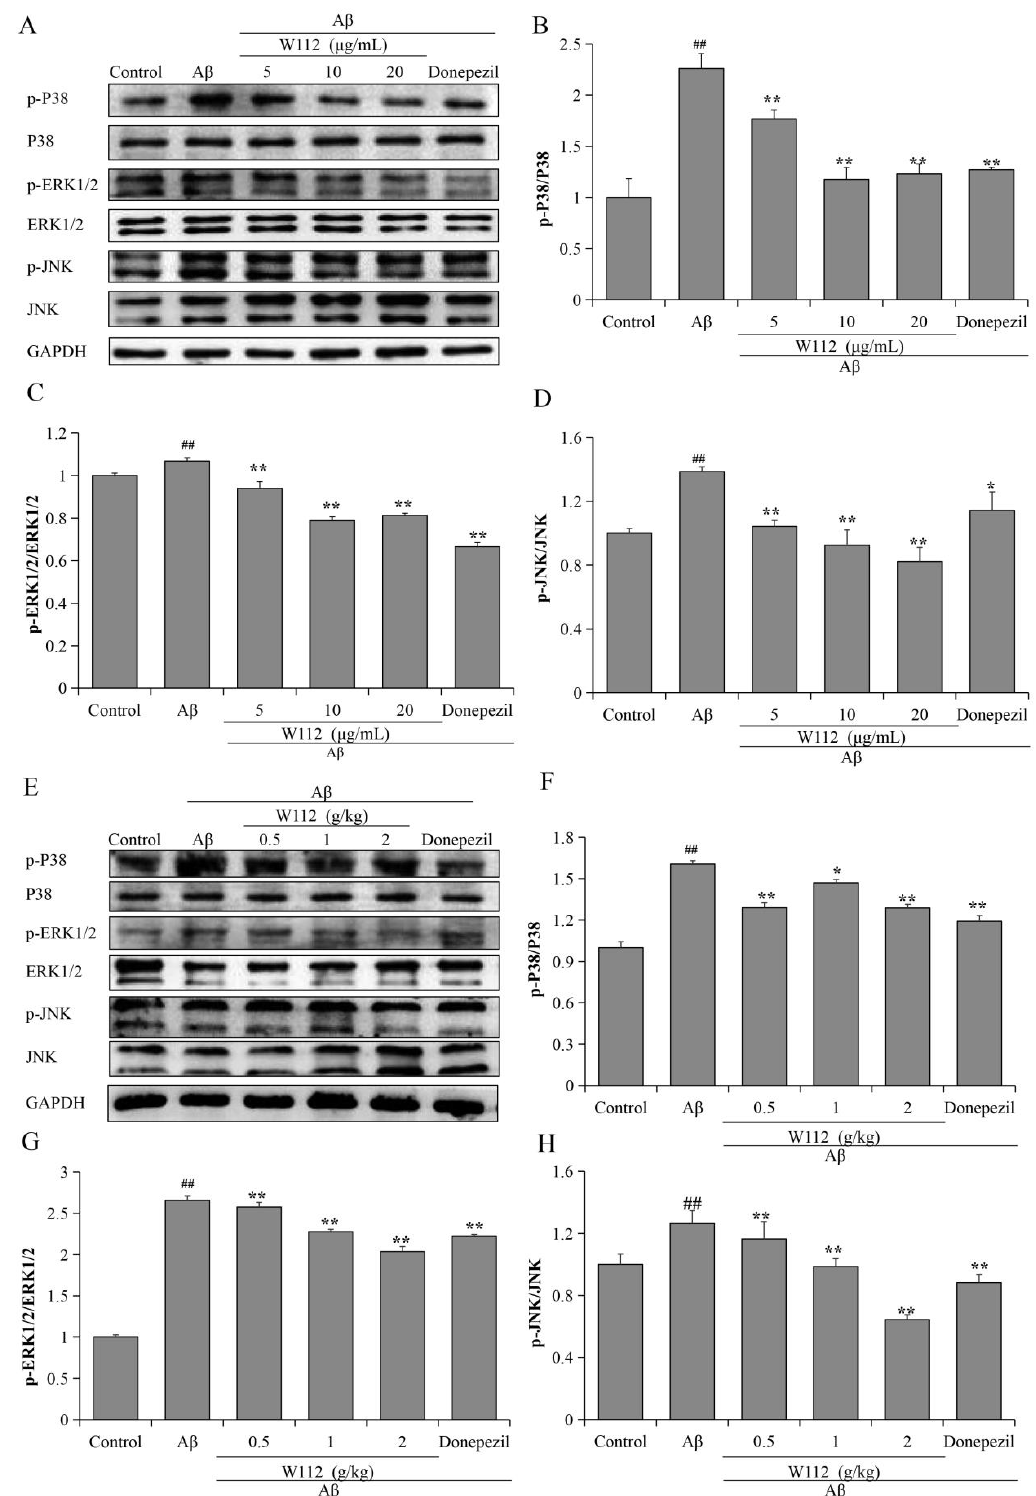
Figure 7. W112 treatment inhibited the activation of MAPK signaling pathway in Aβ 25 – 35 -induced cell and rat models. ( A – D ) The phosphorylation and total levels of p38, ERK1/2, and JNK in PC12 cells were measured by Western blot. n = 3. ( E – H ) The phosphorylation and total levels of p38, ERK1/2, and JNK in the hippocampus were measured by Western blot. n = 8. ## p < 0.01 vs. the control group; * p < 0.05, ** p < 0.01 vs. the model group.